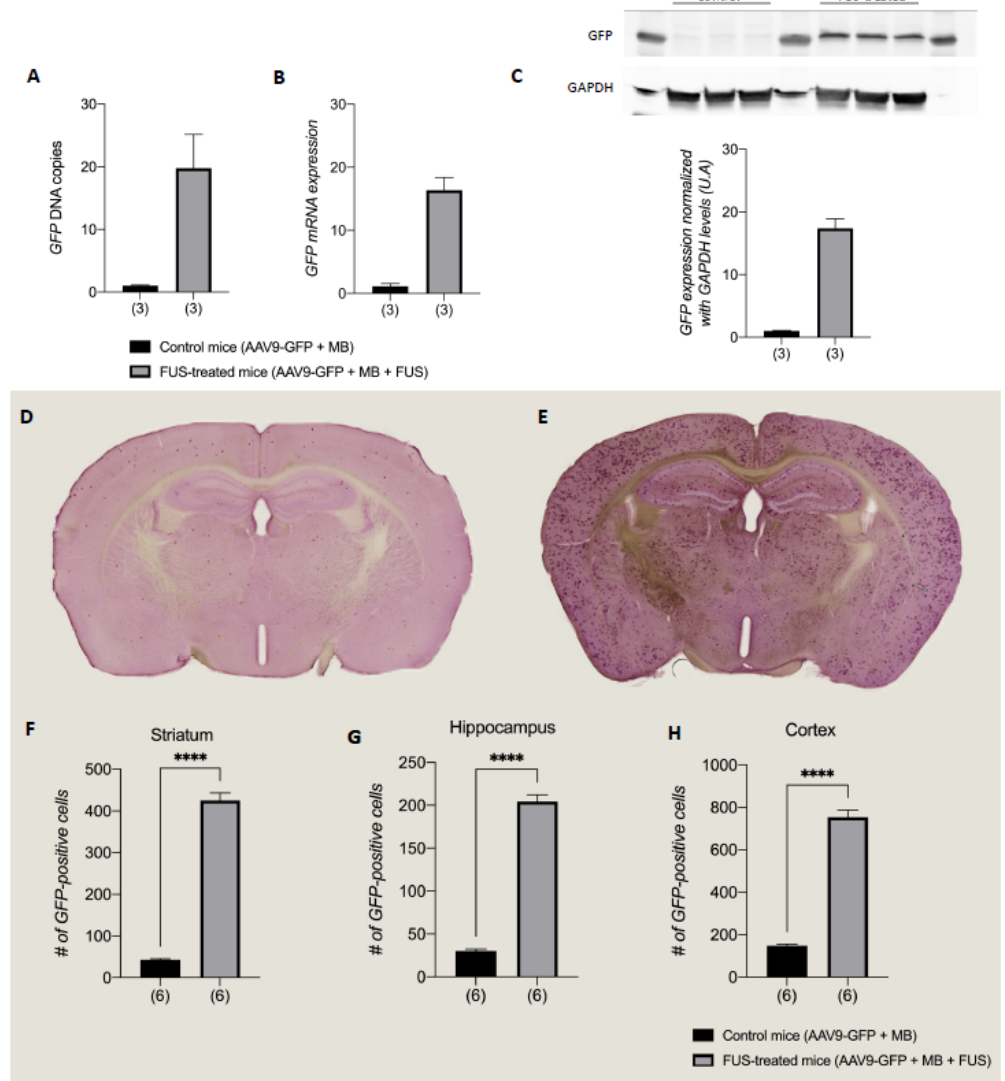
Figure 4. Efficiency studies 1 month after FUS treatment showed an increase of vector quantity, vector expression and number of infected cells in the brain. ( A ): FUS treatment increased AAV9-GFP transduction in the brain (cohen’s d effect size = 3.47). ( B ): GFP cDNA expression was increased in the brain of FUS-treated mice (cohen’s d effect size = 7.28). ( C ): Western blot quantification showed an increase in GFP expression in the brain after FUS treatment (cohen’s d effect size = 10.98). Representative western blot images with the GFP protein stained in black are shown above the graph. ( D – H ): Immunohistochemistry anti-GFP showed an increase in the number of GFP-positive cells in the brain of FUS-treated mice. Representative mages with the GFP protein stained in violet are shown above the graph for control mice ( D ) and FUS- treated mice ( E ). The number of GFP-positive cells was counted in the striatum ( F ), the hippocampus ( G ), and the cortex ( H ). Mean + SEM are represented by vertical bars, ****: p < 0.0001 Mann–Whitney rank-sum test, and ( n ) number of animals per group.